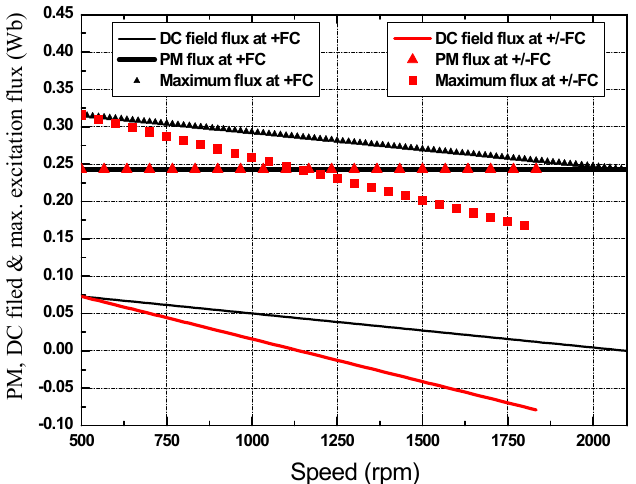
Figure 12. Efficiency and power factor excitation at reduced and reversed FC. Figure 12. E ffi ciency and power factor excitation at reduced and reversed FC.